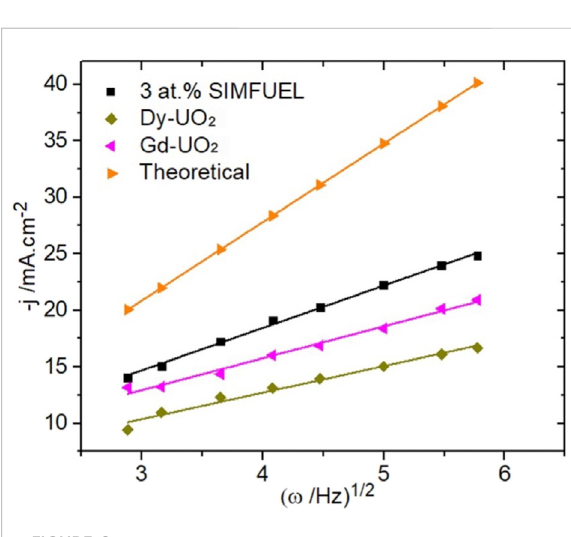
FIGURE 6 Levich plots of the current densities measured at − 1.1 V for the three different UO 2 electrodes in a 0.1 mol.L − 1 NaCl solution containing 0.02 mol.L − 1 of H 2 O 2 and 0.05 mol.L − 1 of NaHCO 3 (pH = 9.7). The theoretical curve was calculated for this [H 2 O 2 ] using the Levich equation Santos et al.,